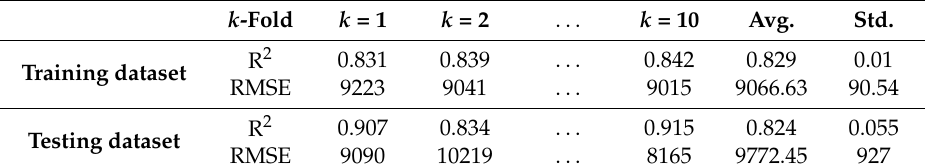
Figure 10. Fitted plot of SVR. Table 10. 10-fold CV of SVR.